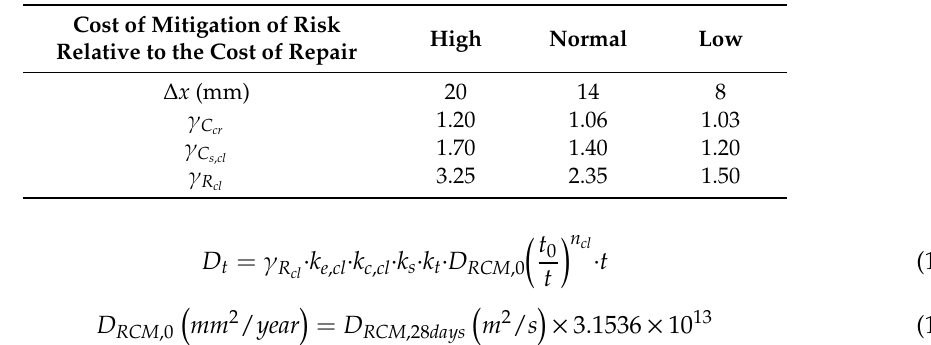
Table 10. Relationship between the failure probability 𝑃 (cid:3033) and the reliability index 𝛽 .